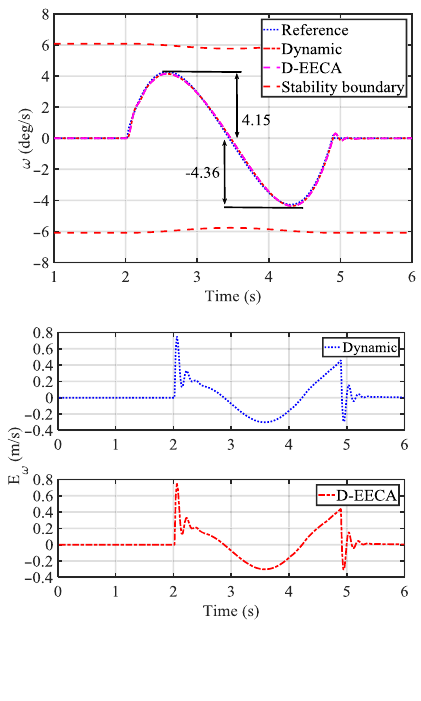
Figure 9 The heading angle of A-IWMs EV and tracking errors